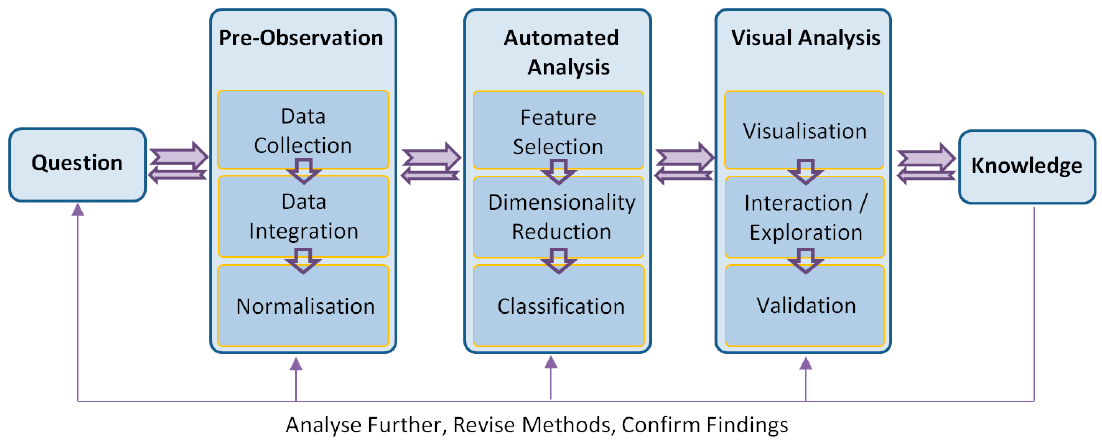
Figure 1. The visual analytics framework for complex genomics data.